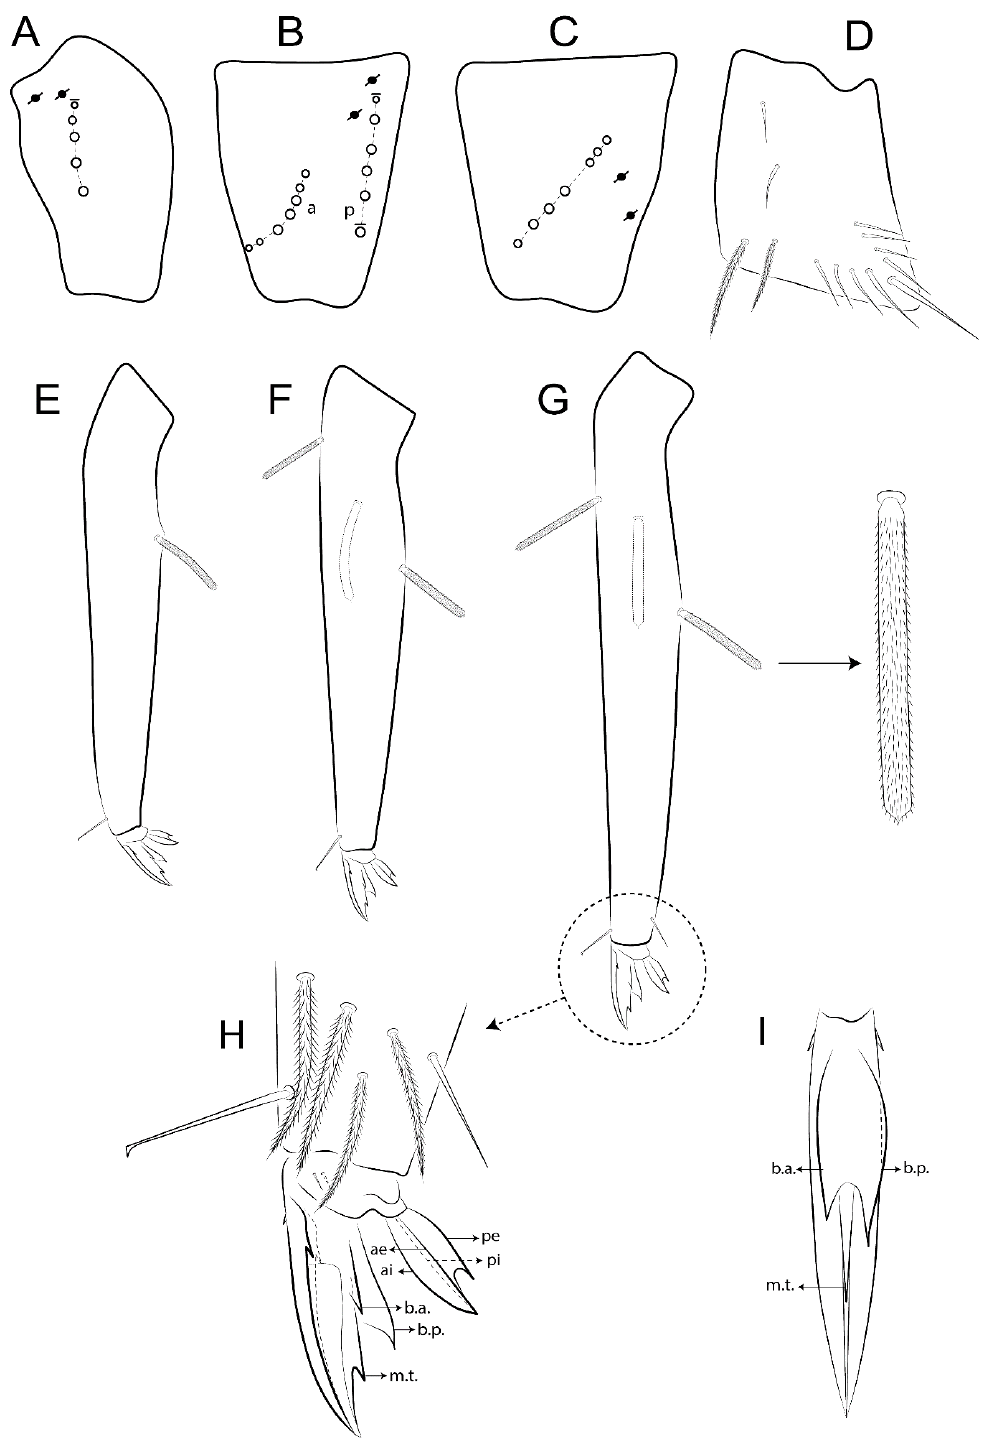
Figure 10. Pseudosinella acantholabrata sp. nov.: legs chaetotaxy. ( A – C ) subcoxa I–III, respectively; ( D ) trochanteral organ; ( E – G ) tibiotarsus I–III, respectively (anterior view), arrow indicates modified chaetae; ( H ) distal tibiotarsus and empodial complex III (anterior view); and ( I ) unguis (inner view).